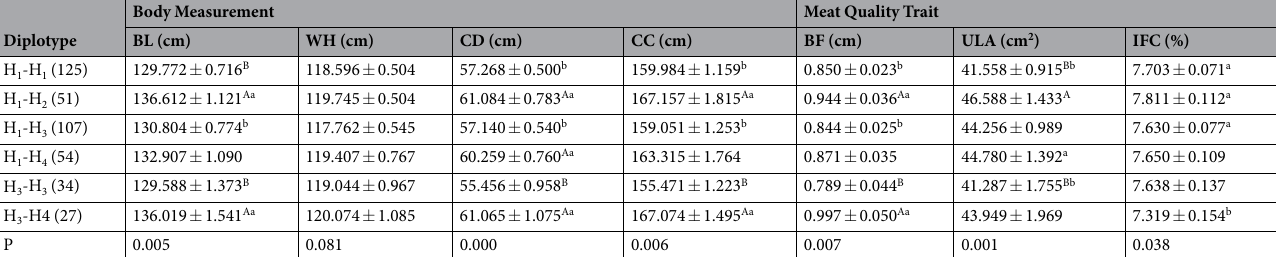
Table 4. Associations of diplotypes with body measurements in Qinchuan cattle. Values are shown as the means ± standard error. Values with different superscripts in the same column differ significantly at P < 0.05 (a,b) and P < 0.01 (A,B) after Bonferroni correction. Body length (BL),withers height (WH), chest depth (CD), content (IFC).